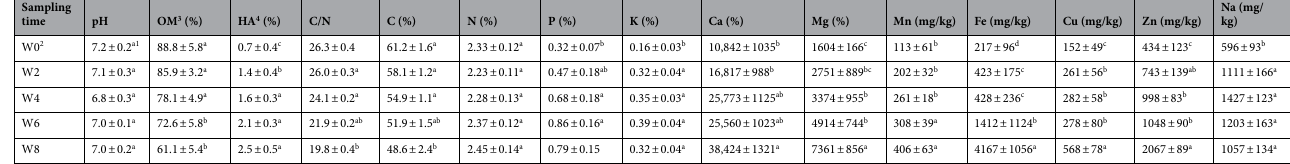
Table 3. The chemical properties of pig manure at different sampling stage. 1 Different letters indicate significantly different results by LSD tests at p < 0.05. 2 0, 2, 4, 6, 8 week after compost. 3 Organic matter. 4 Humic acid.